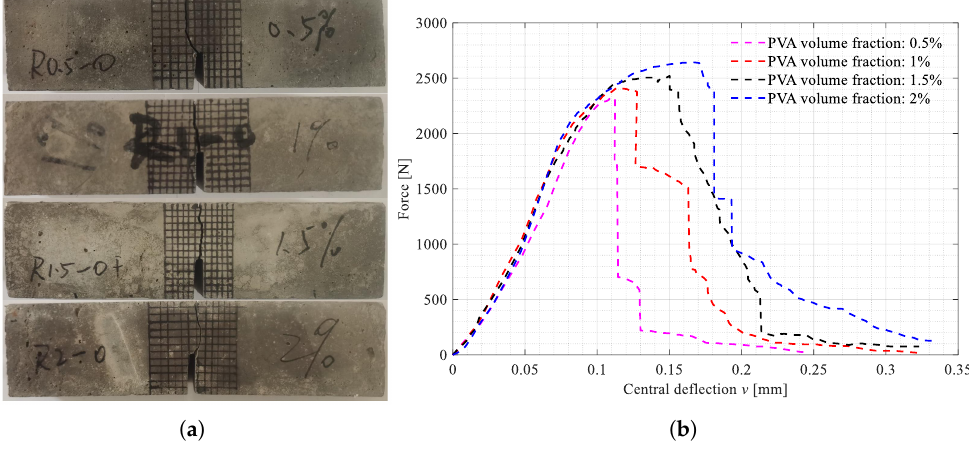
Figure 7. The broken beam specimens with C l = 0 mm and the central deflection-force diagrams. ( a ) Broken specimens with C l = 0 mm; ( b ) Central deflection-force